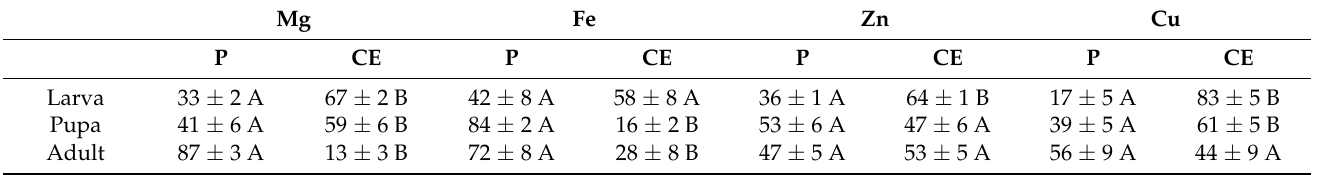
Table 3. Element distribution between pellets (P) and cytosolic extracts (CE) from the European hornet ( V. crabro ). Data are reported as mean ± standard deviation (n = 6 for adult specimens and n = 2 for larvae and pupae) and are expressed in percentages (%). For each metal, different capital letters indicate significant differences between pellets and cytosolic extracts. Mg Fe Zn Cu P CE P CE P CE P CE Larva 33 ± 2 A 67 ± 2 B 42 ± 8 A 58 ± 8 A 36 ± 1 A 64 ± 1 B 17 ± 5 A 83 ± 5 B Pupa 41 ± 6 A 59 ± 6 B 84 ± 2 A 16 ± 2 B 53 ± 6 A 47 ± 6 A 39 ± 5 A 61 ± 5 B Adult 87 ± 3 A 13 ± 3 B 72 ± 8 A 28 ± 8 B 47 ± 5 A 53 ± 5 A 56 ± 9 A 44 ± 9